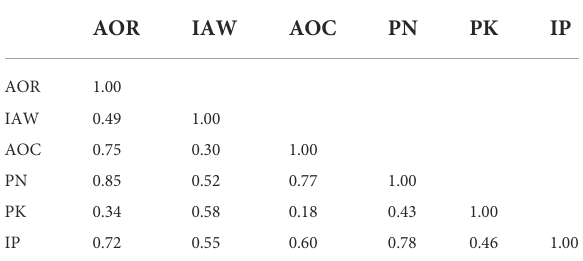
TABLE 4 Discriminant validity